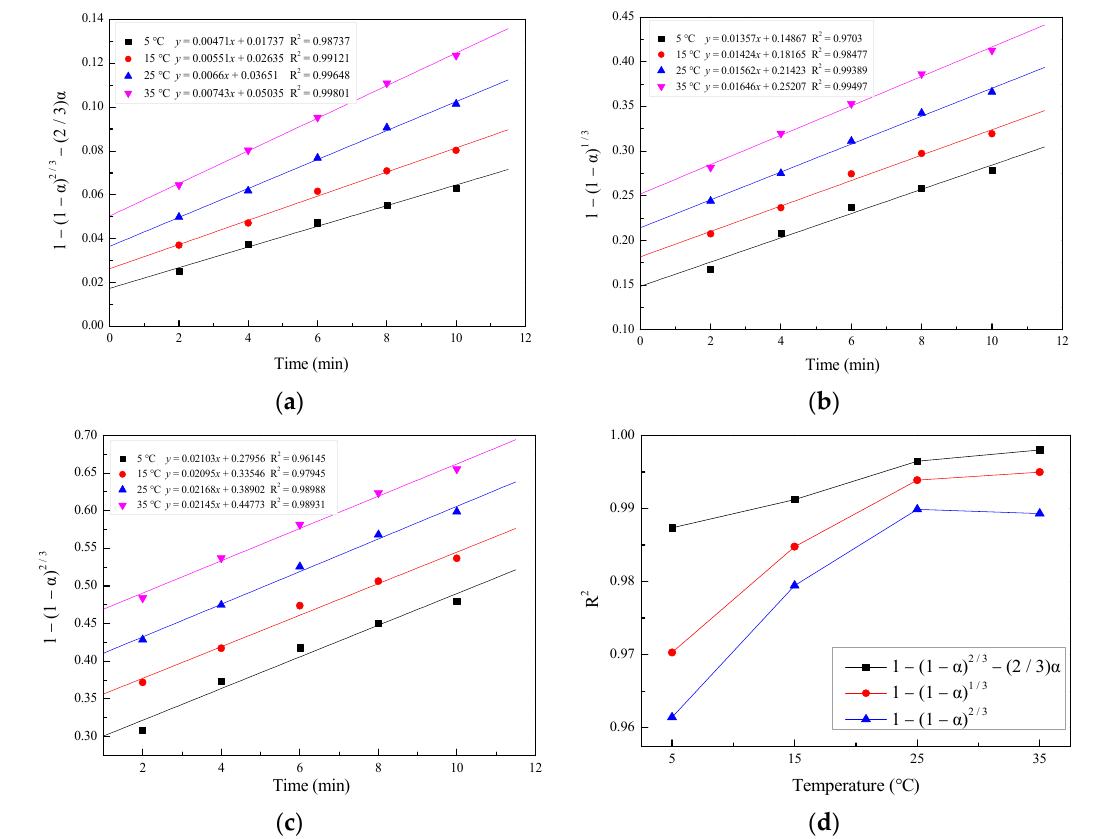
Figure 9. Plots of ( a ) 1 − (1 − α ) 2/3 − (2/3) α , ( b ) 1 − (1 − α ) 1/3 , and ( c ) 1 − (1 − α ) 2/3 versus time for various temperatures and ( d ) R 2 versus temperature for various equations.